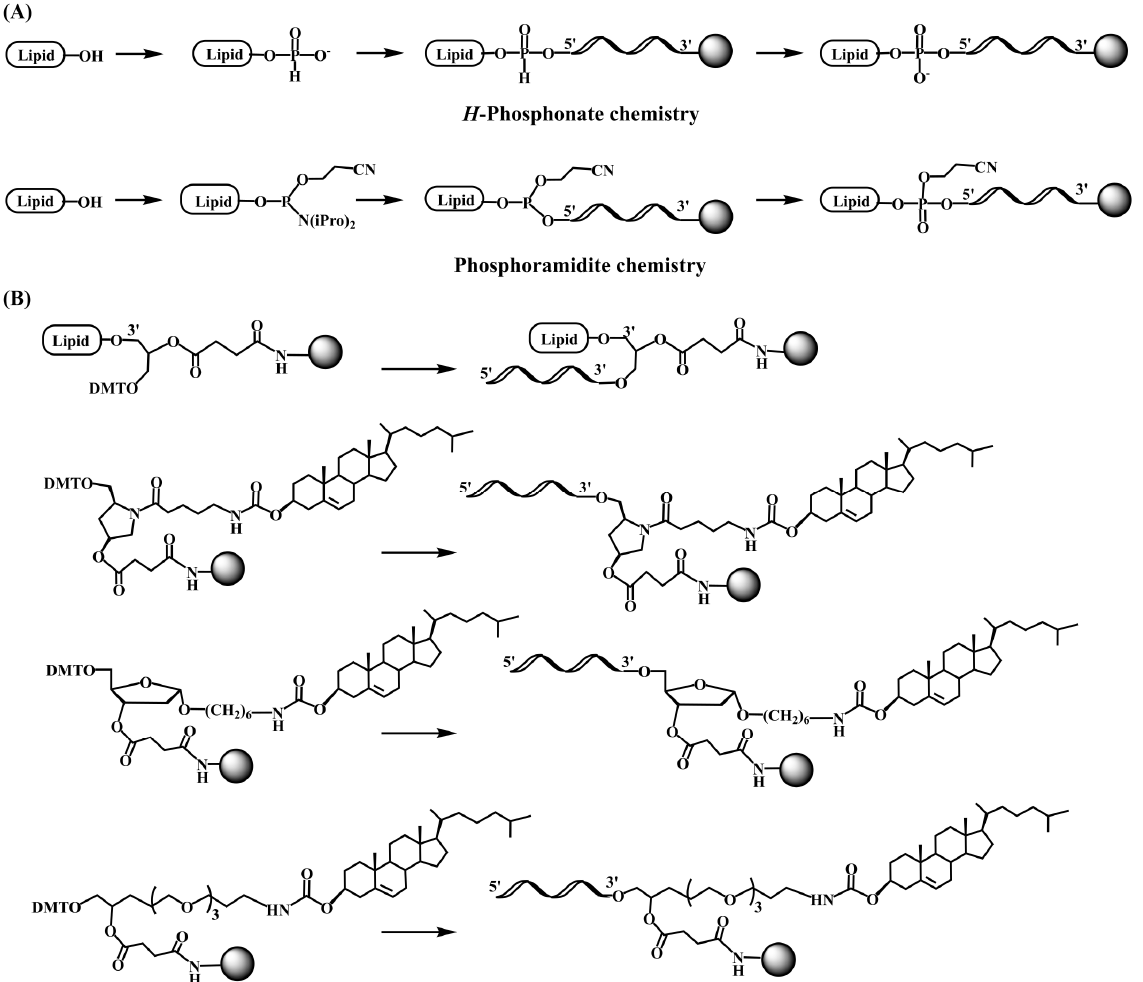
Figure 1. Synthetic approaches for the incorporation of lipids to the 5′ and 3′ end of an oligonucleotide. ( A ) H -phosphonate [22–24] and phosphoramidite chemistry [29,31] and ( B ) Different cholesterol functionalized solid supports [30,32].